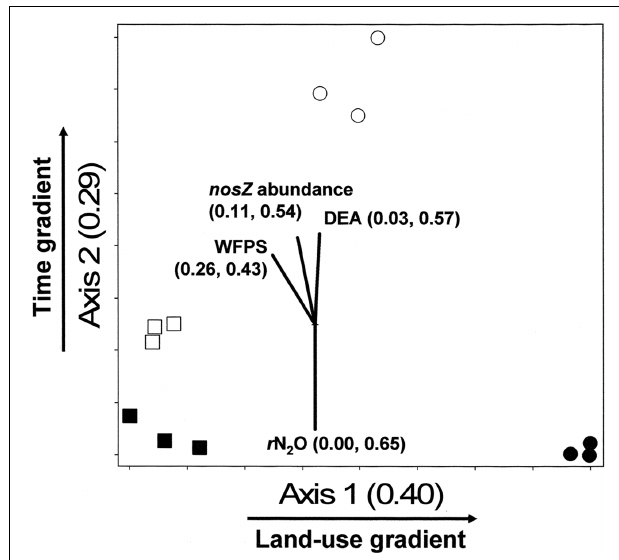
FIGURE 6 | Non-metric multidimensional scaling (NMS) ordination of denitrifying communities based on presence/absence of operational taxonomic units (OTUs) defined by nosZ RFLP patterns. (cid:2) = Jun 01; ◦ = Jun cultivated wetlands (CW). (cid:3) = Sep 12; cultivated wetlands (BC). • = Sep 12; uncultivated wetlands.Vectors 01; uncultivated wetlands. show the direction and magnitudes of the correlation coefficient ( r 2 ) between NMS ordination axes and functional variables.The r 2 for the correlation between functional variable and axis 1 and axis 2 are in parentheses (in the order r 2 to axis 1, r 2 to axis 2). Note: only functions with r 2 ≥ 40% to either NMS axes are shown in joint plots.